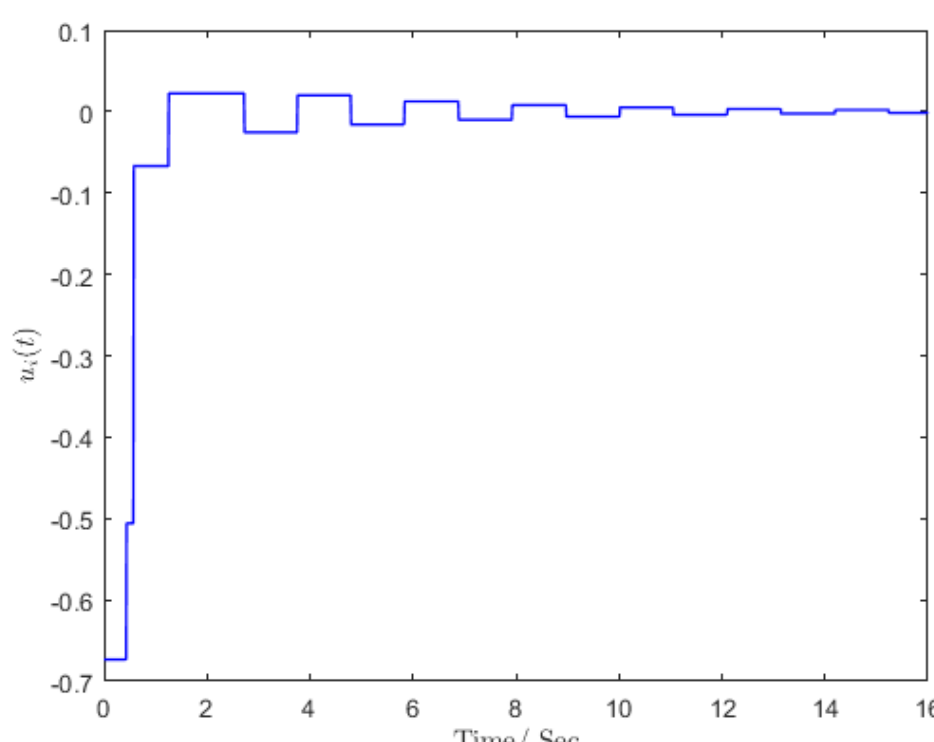
Figure 1. State of the system with τ = 0.1.